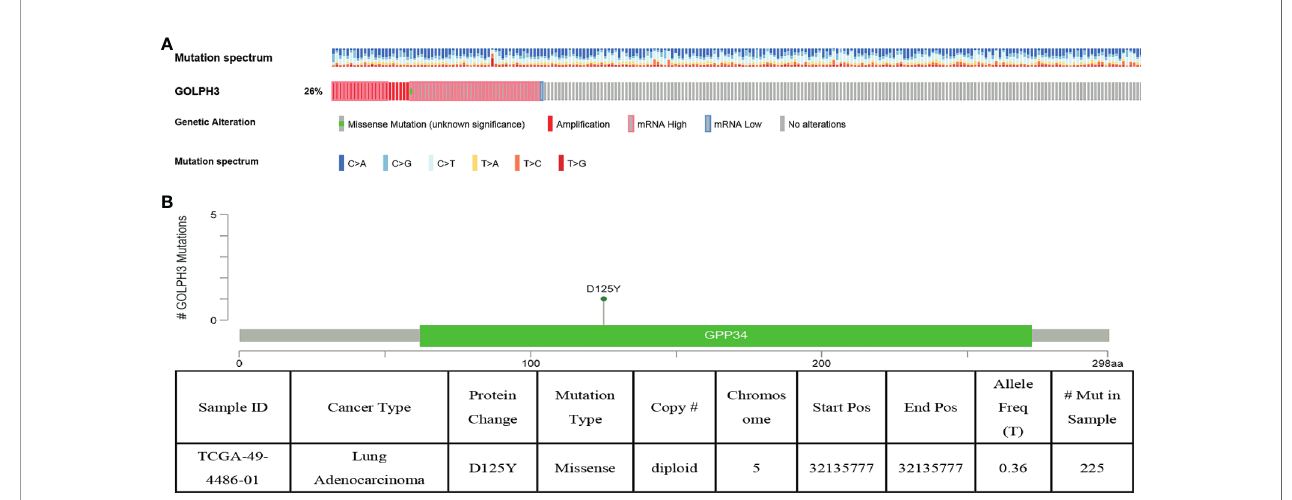
( Figure 8I ), which further intimated that miR-142-5p targeted negative regulation of GOLPH3.